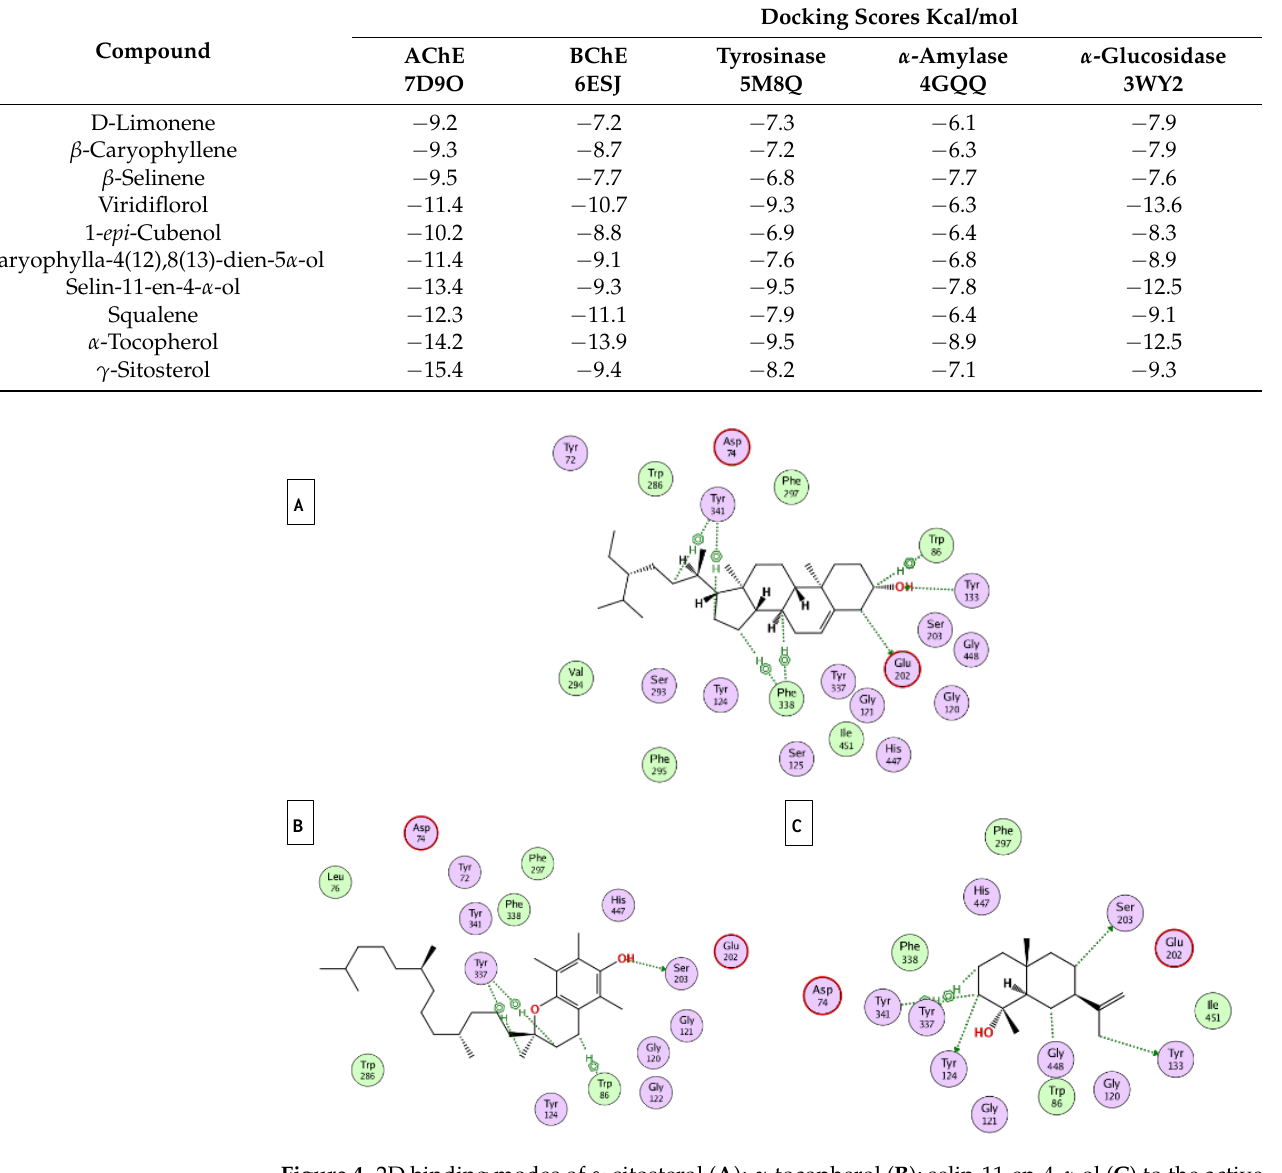
Figure 4. 2D binding modes of γ -sitosterol ( A ); α -tocopherol ( B ); selin-11-en-4- α -ol ( C ) to the active binding sites of AChE.